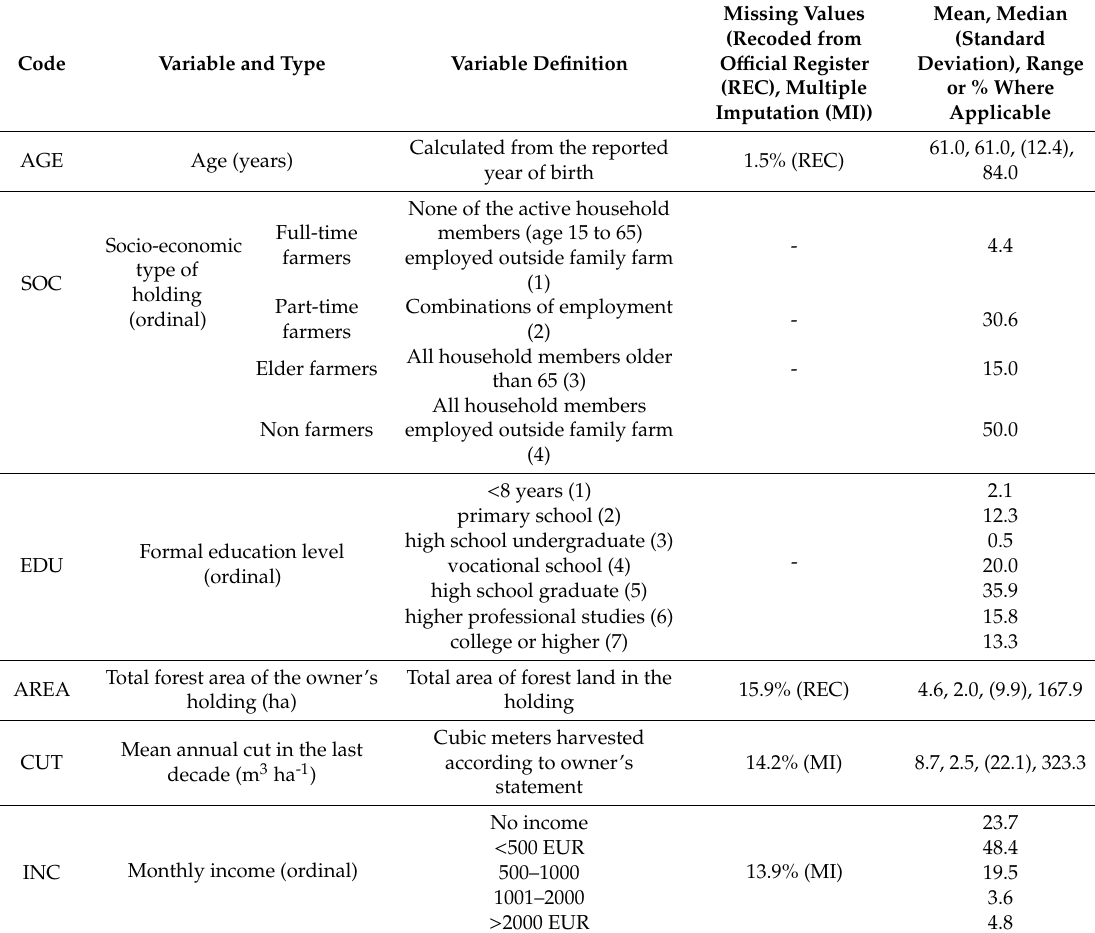
Table 1. Structural attributes of private forest owners and forest